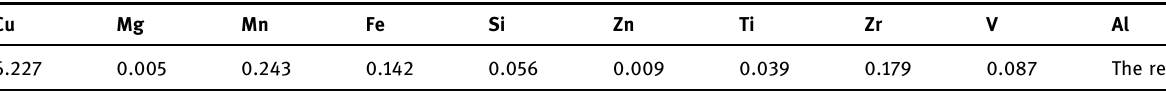
Table 1: Chemical composition of 2219 aluminum alloy ( %